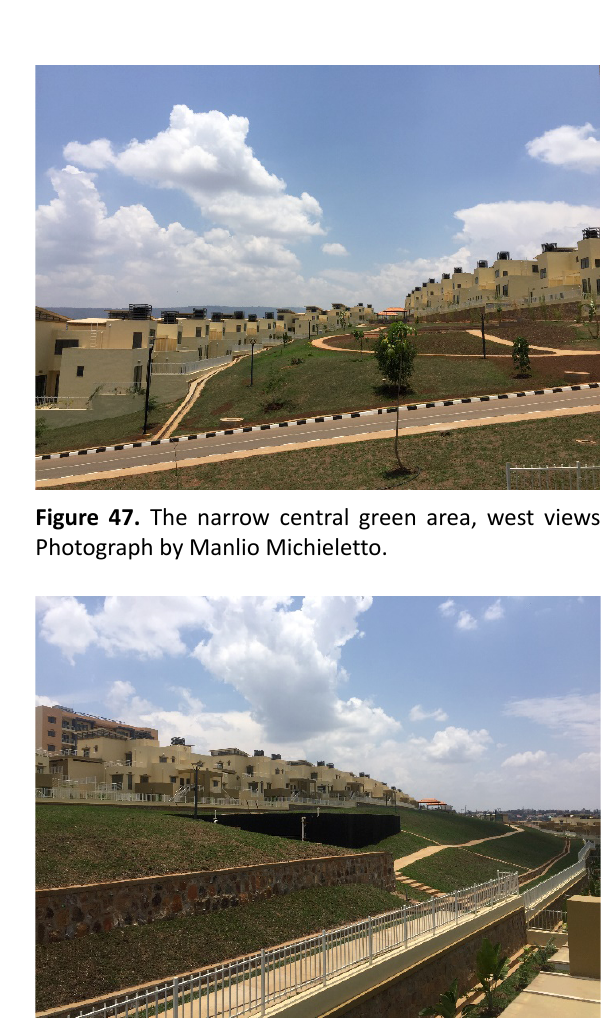
Figure 44. The Umudugudu Kigali Vision: Different dwelling types. Drawing by Manlio Michieletto.